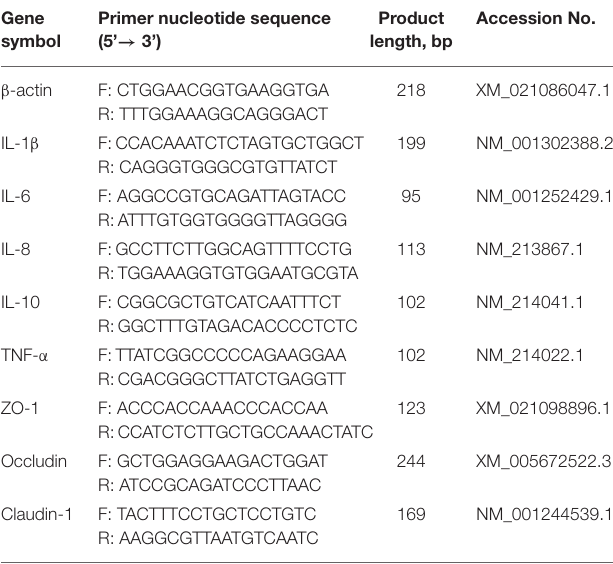
TABLE 3 | Effect of dietary AMP supplementation on the growth performance of pigs 1